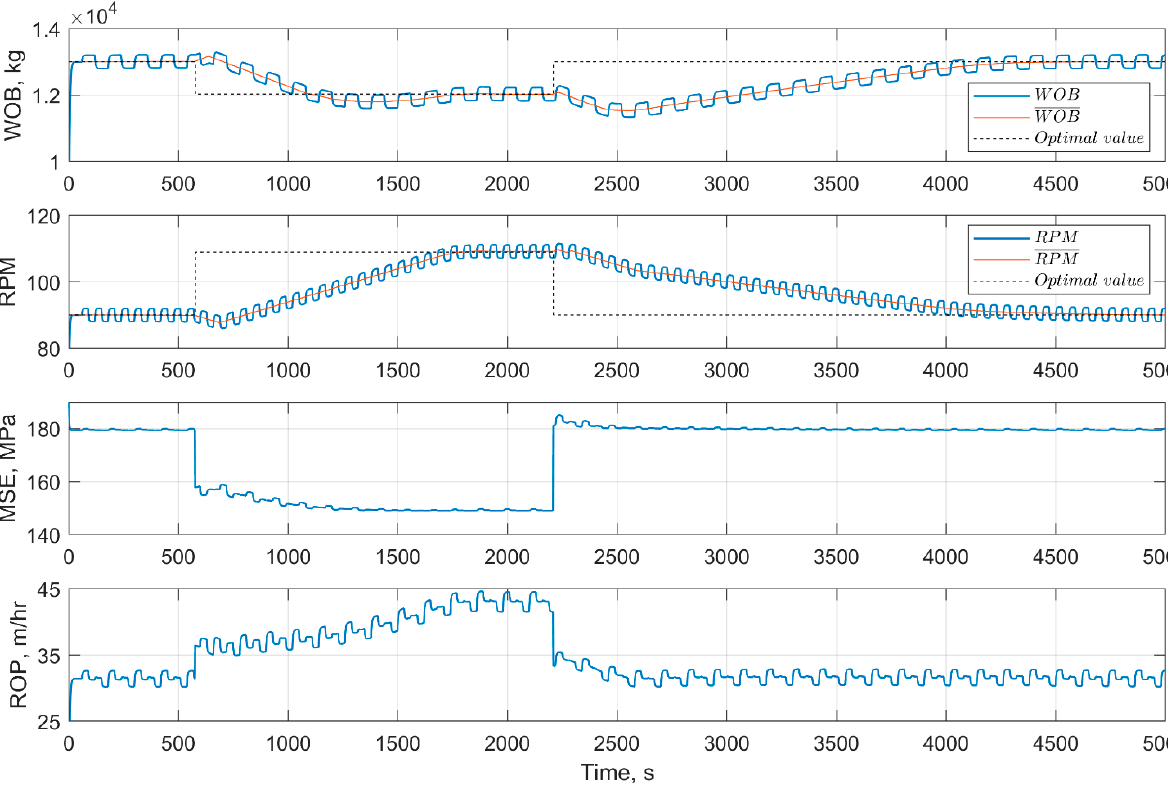
Figure 16. Simulation run 5, drilling through 5 m of formation A , 15 m of formation B and then returning to drilling in formation A .